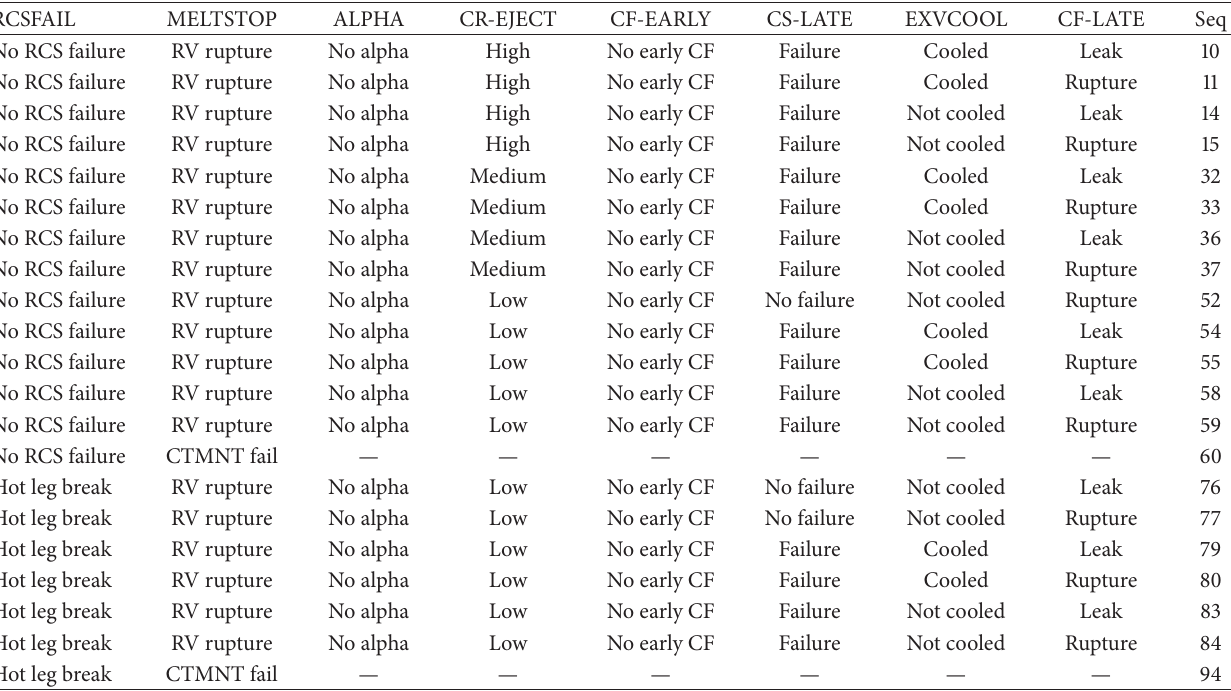
Table 6: Level 2 PSA internal event affected by CFVS.